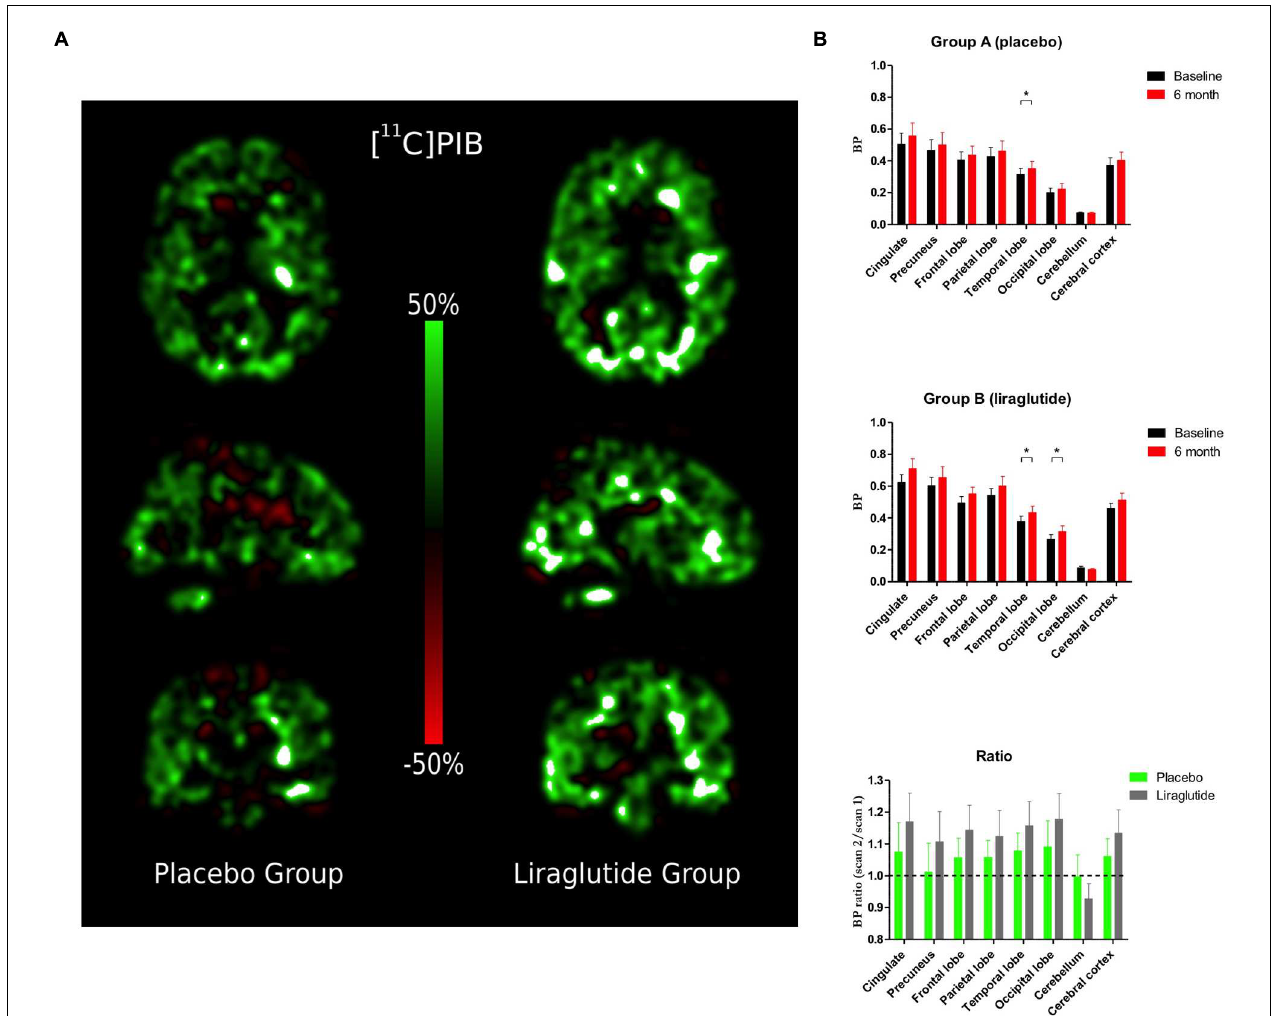
FIGURE 1 | (A) Percentage change in Binding Potential in the brain (BP ND ) between baseline scan and 6-month follow-up. (B) Binding Potential in the brain (BP ND ) in the cingulate cortex, precuneus, frontal, parietal, temporal, and occipital lobes, cerebellum and cerebral cortex at baseline and the Ratio Session 2/1 in the placebo group and the liraglutide group. ∗ P <